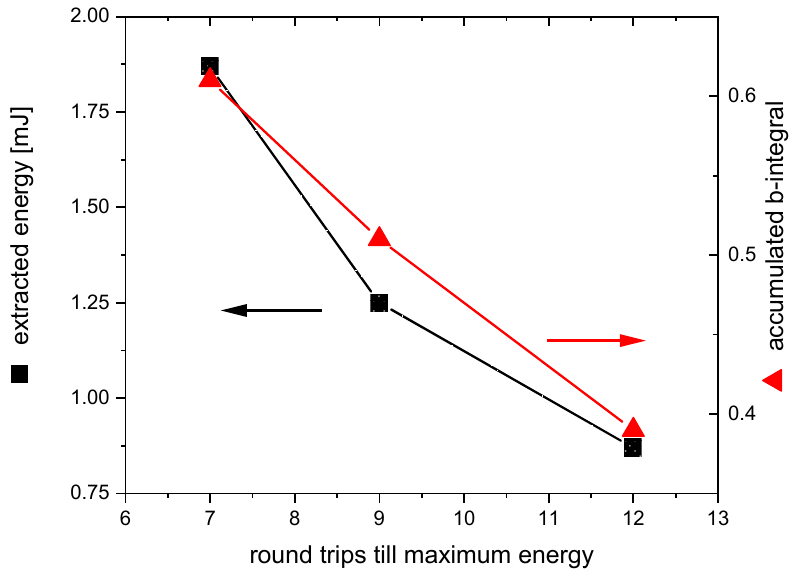
Figure 6. Calculation of extracted energy (black squares) and accumulated B-integral (red triangles) vs. the number of roundtrips until extraction at gain saturation. More roundtrips (less pump energy) leads to lower accumulated B-integral and lower extracted energies.